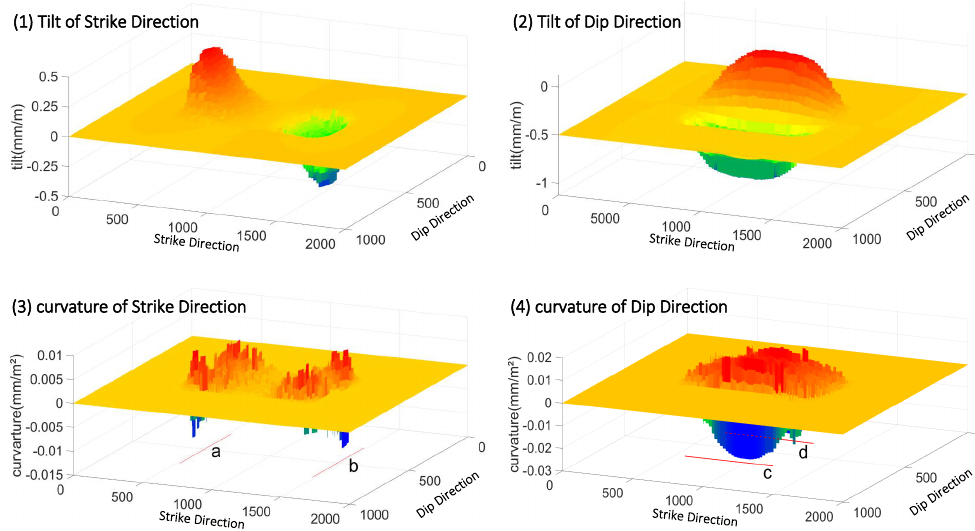
Figure 6. Tilt and curvature in the strike direction and dip direction.The borders of the positive and negative areas are the lines indicated by a , b , c , and d in graphs ( 3 ) and ( 4 ).